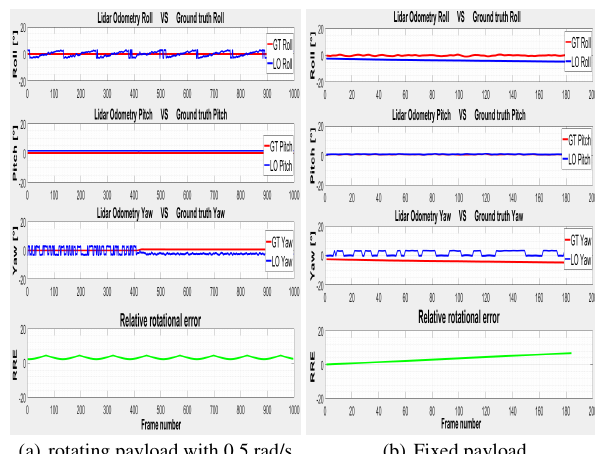
Figure 8. Comparison between fixed and rotation payload on LiDAR odometry orientations